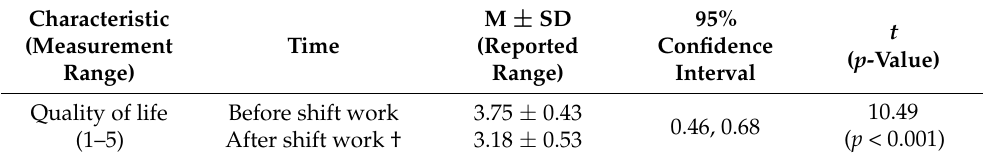
Table 3. Quality of life according to measurement time (before and after shift work) ( N = 88).